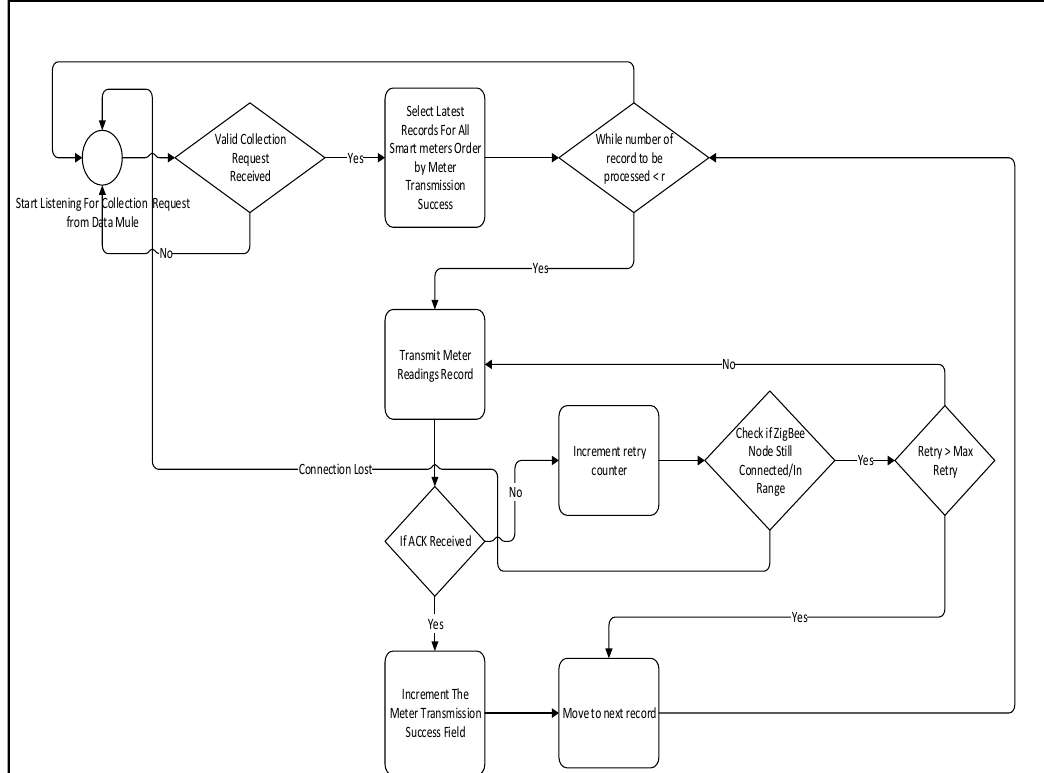
Figure 7. Data Collector Transmission Flow Chart (Low number of meters).